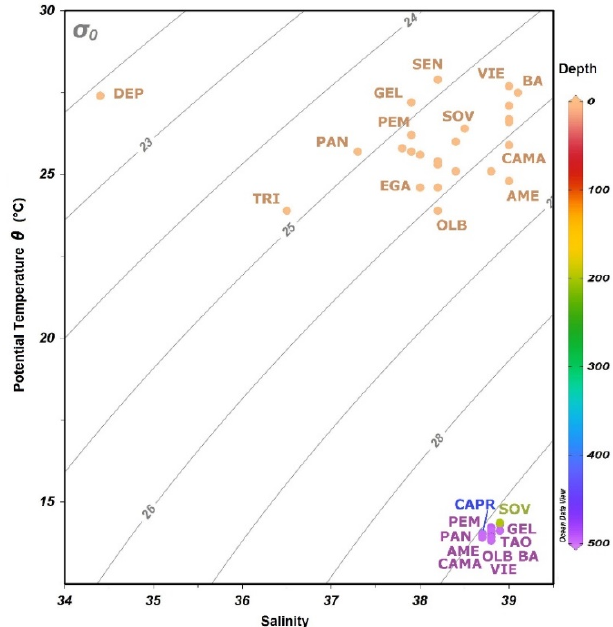
Figure 5. T-S diagram of superficial and deep stations. Color bar shows the depths (m). Not all stations have been indicated at each group (epipelagic and mesopelagic).